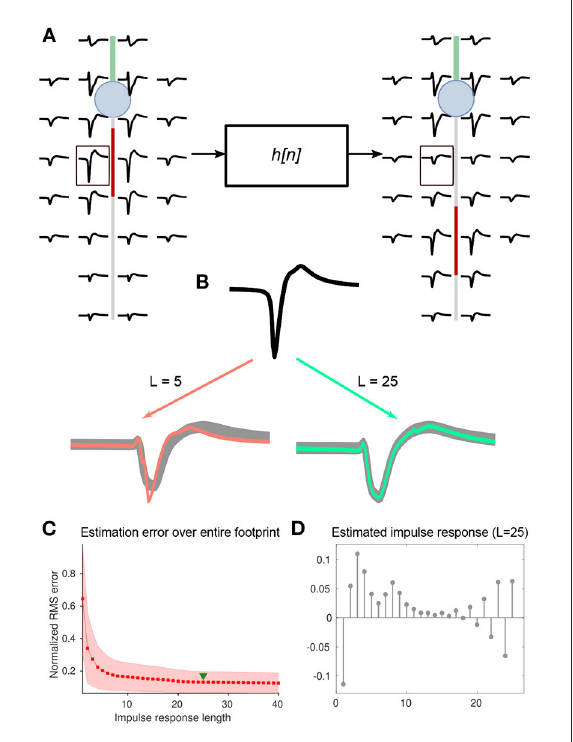
FIGURE6 (A) Changes in each pair of extracellular footprints, associated with AIS relocation, were modeled as a set of M linear transformations, each associated with an impulse response, h m [ n ], where m ∈ { 1, ··· , M } denotes the electrode number, and M is the number of electrodes in the extracellular footprint. Electrode-wise impulse responses of length L =25 were estimated using the inverse of the convolution matrix (see methods). (B) Illustration of the impulse response estimation for a single electrode marked (black box) in (A) . The baseline and transformed waveforms are shown in black and gray respectively. Overlays of transformed waveforms, estimated using the impulse response of lengths L = 5 and 25, are shown in orange and green, respectively. (C) The RMS error normalized and averaged across electrodes decreased steadily with increasing impulse-response lengths. We used a length of 25 for further analyses (green triangle). (D) A sample impulse response (L = 25), computed for the waveform transformation at the electrode shown in (B)